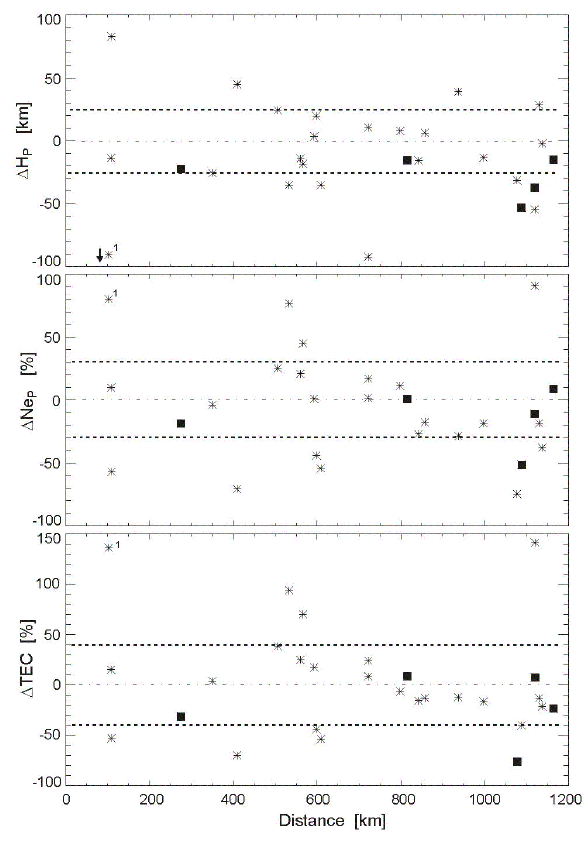
Fig. 4. Correlation plots of F2 peak height difference, 1 H p , rela- tive difference of F2 peak densities, 1 Ne p , and relative difference of total electron content, 1 TEC (compiled for height ranges 150– 420km) as function of the distance of the corresponding F2 peaks (taken from calculations as displayed in Fig. 1)